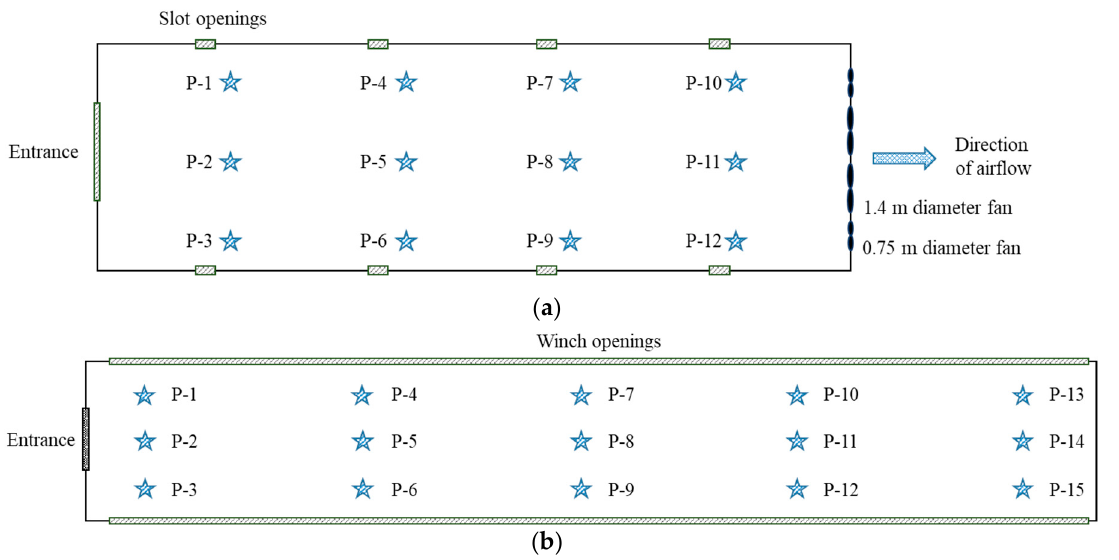
Figure 4. Sensor locations for air temperature and relative humidity in mechanically and naturally ventilated duck houses. ( a ) Schematic information of mechanically ventilated duck house; ( b ) schematic information of naturally ventilated duck house. Air temperature and relative humidity